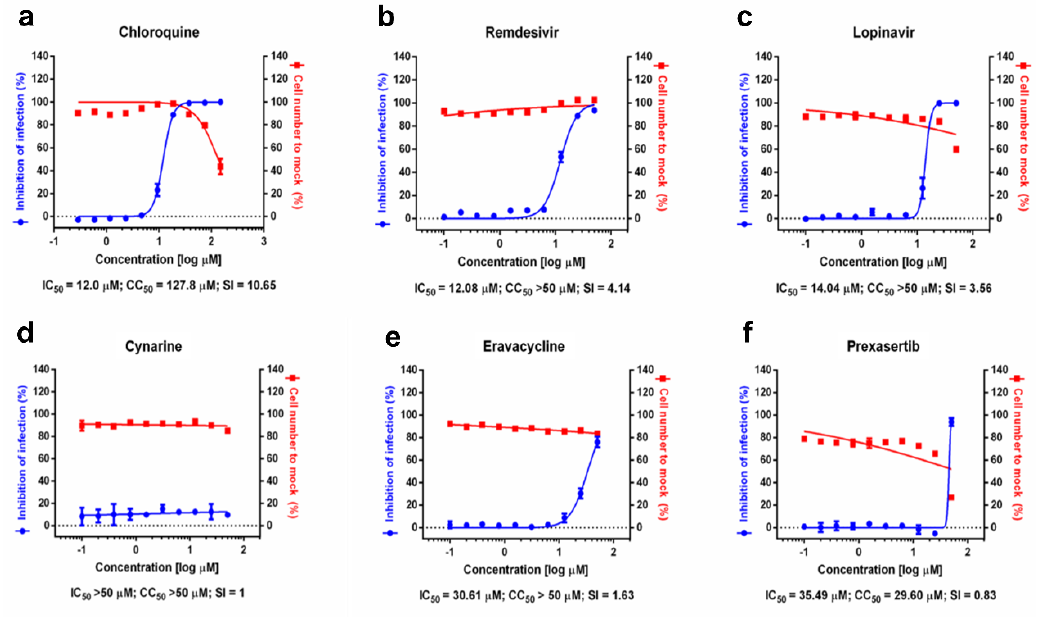
Figure 3. Inhibition of SARS-CoV-2 infection in VeroE6 cells ( a–f ). The blue squares represent inhibition of SARS-CoV-2 infection (%), and the red triangles represent cell viability (%). Mean standard deviation (SD) was calculated from duplicate